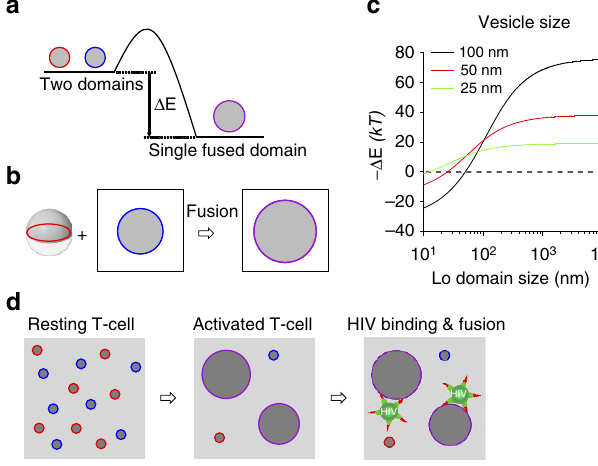
Figure 7 | Release of boundary energy by domain coalescence. ( a ) Schematic diagram illustrating the change of boundary energy by domain coalescence. ( b ) A symmetric vesicle with two equally sized Lo- and Ld-phase hemispheres fuses with a Lo domain in a planar membrane. ( c ) Change of boundary energy for the reaction shown in b as a function of Lo domain size in the planar membrane for vesicles of different sizes. Domain fluctuations are not considered in this simple geometrical model (see text). ( d ) Schematic diagram illustrating biological implications of domain coalescence in T-cell activation on HIV binding and fusion at domain boundaries. The small domains shown in resting T-cells may actually be dynamic fluctuating clusters or nanodomains of receptors and lipids 29 , but even then, the concept of lateral assembly of multiple clusters and domain growth during T-cell activation is still